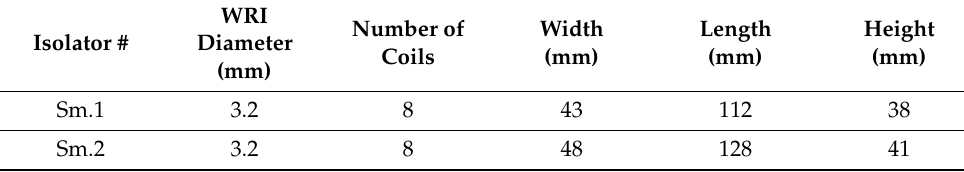
Table 6. Specifications of the new small